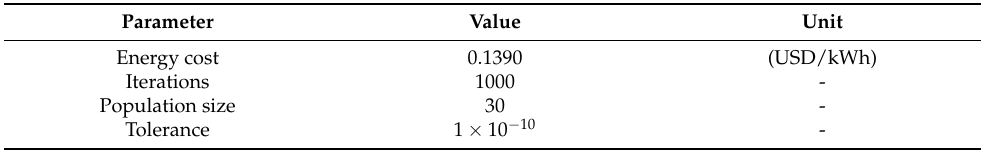
Table 4. General simulation parameters.